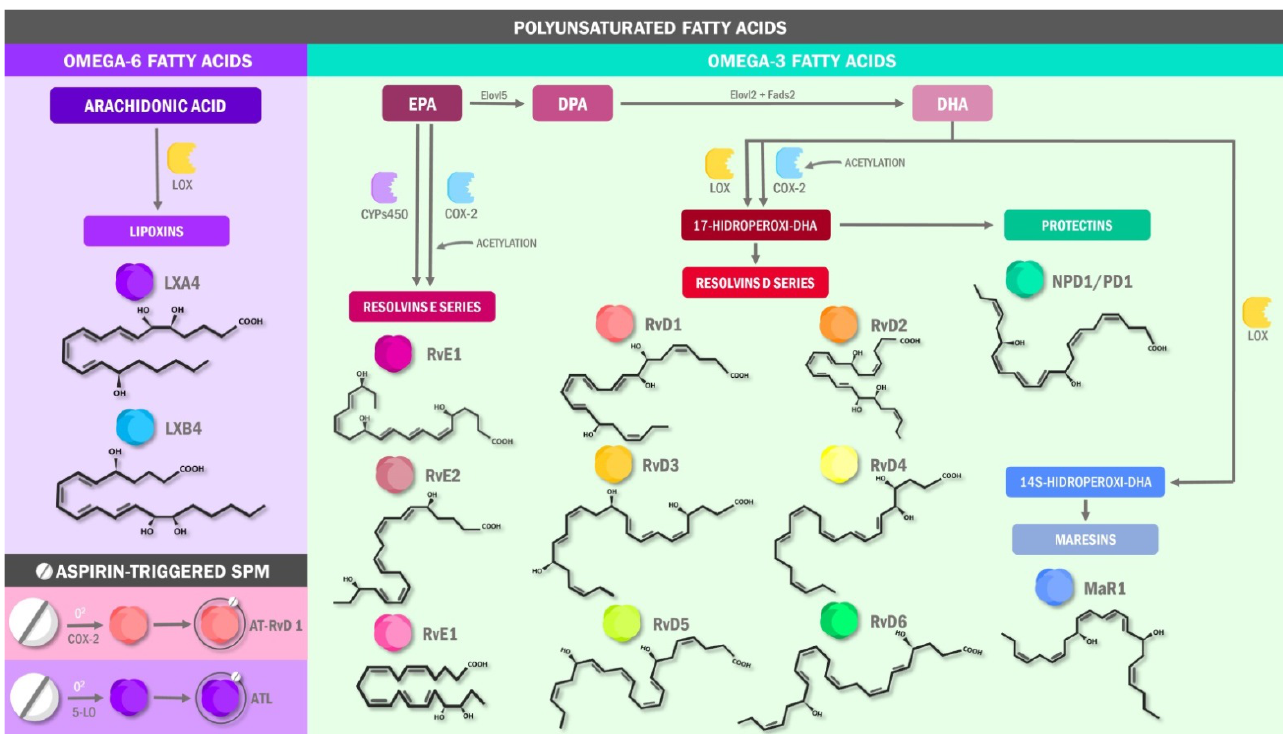
Figure 1. Metabolism of specialized pro-resolving lipid mediators. EPA: eicosapentaenoic acid; DPA: docosapentaenoic acid; DHA: docosahexaenoic acid; RvE1: resolvins E1; RvE2: resolvins E2; RvE3: resolvins E3; RvD1: resolvins D1; RvD2: resolvins D2; RvD3: resolvins D3; RvD4: resolvins D4; RvD5: resolvins D5; RvD6: resolvins D6; NPD1: neuroprotectins 1; MaR1: maresins 1; LXA4: lipoxins A4; AT-RvD: aspirin-triggered resolvin D1; ATL: aspirin-triggered lipoxins; LOX: lipoxygenases; COX-2: cyclooxygenase 2; CYP: cytochromes P450 enzymes.